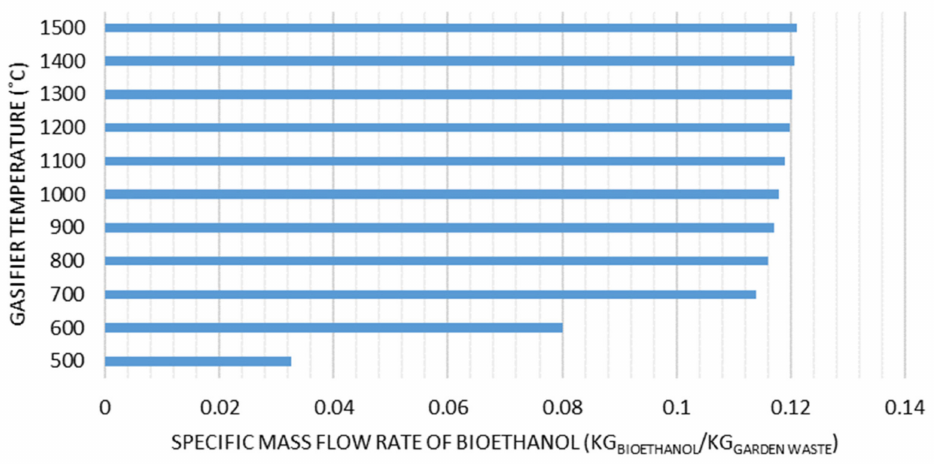
Figure 5. E ff ect of gasification temperature on specific mass flow rate of bioethanol